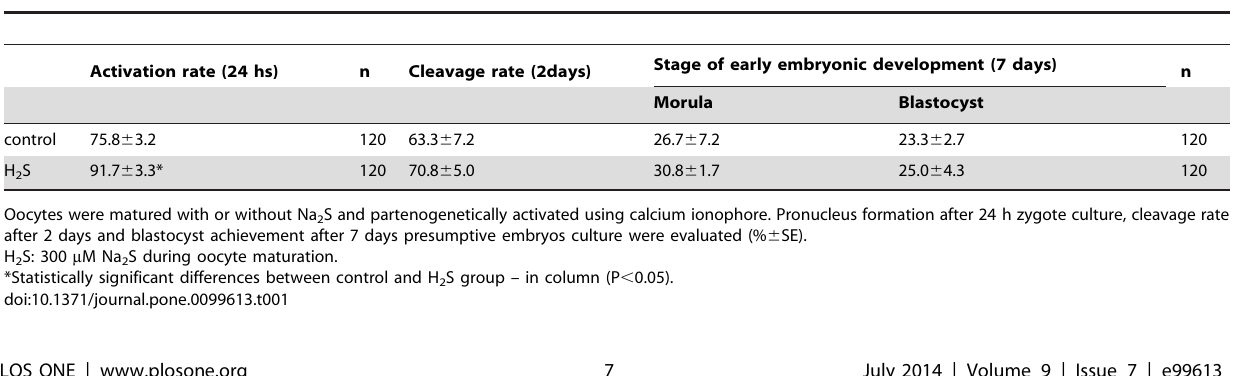
Table 1. Effect of Na 2 S on partenogenetic development of porcine